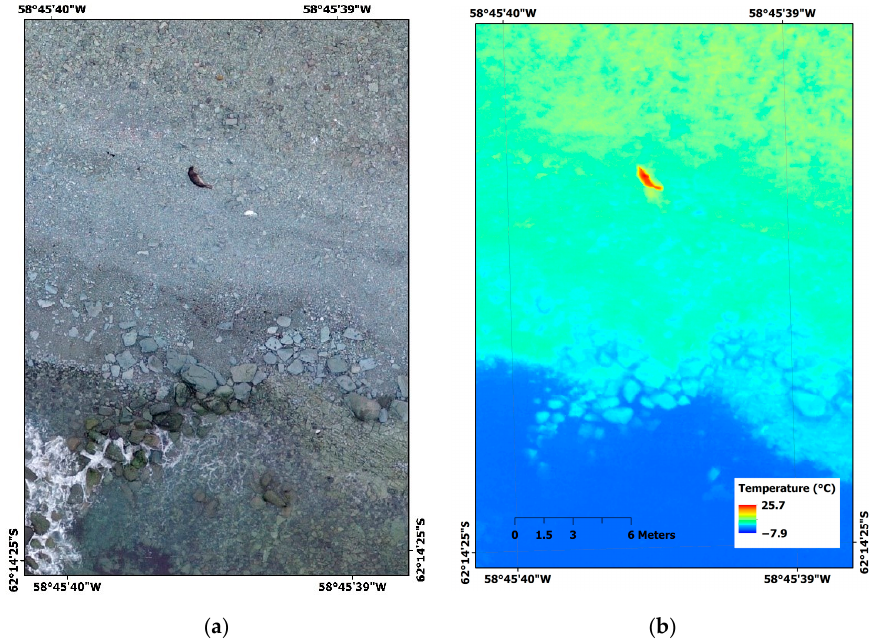
Figure 4. Southern elephant seal ( Mirounga leonina ) captured by RPAS-based RGB and thermal images in Barton Peninsula, King George Island, Antarctica. ( a ) Mosaicked RGB image and ( b ) coregistered mosaicked thermal image to mosaicked RGB image.